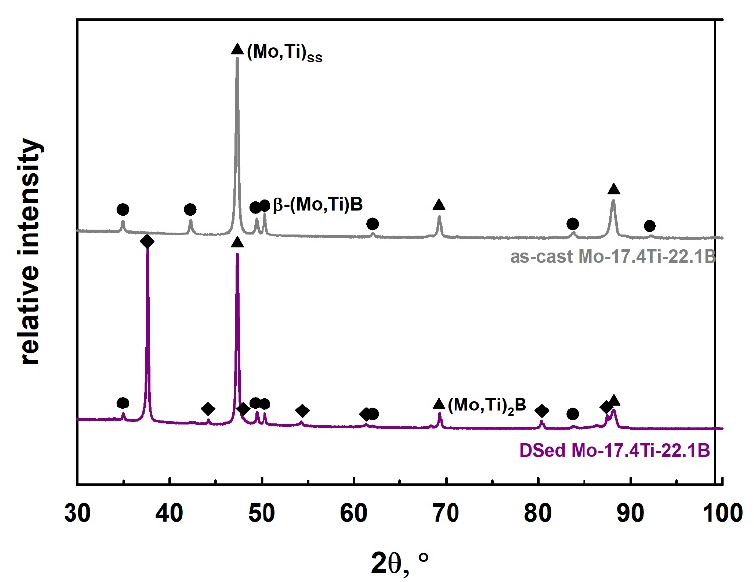
Figure 5. Comparison of the obtained XRD pattern of Mo-17.4Ti-22.1B in the as-cast and DSed state (longitudinal direction).